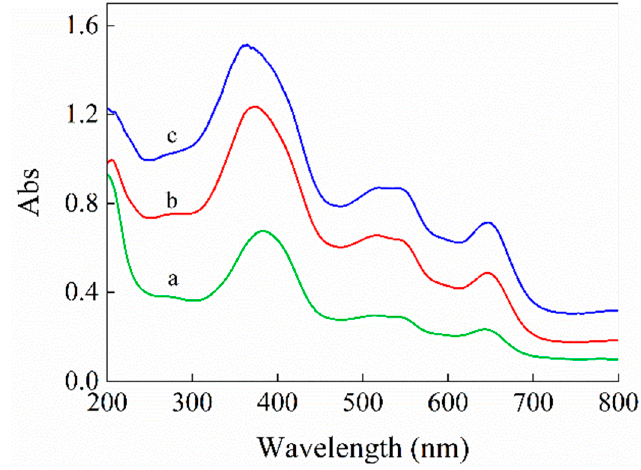
Figure 8. DRS spectra of n-hemin/PAN with different hemin loading capacities: ( a ) 0.8 mg g −1 , ( b ) 14.3 mg g −1 , ( c ) 29.1 mg g −1 .